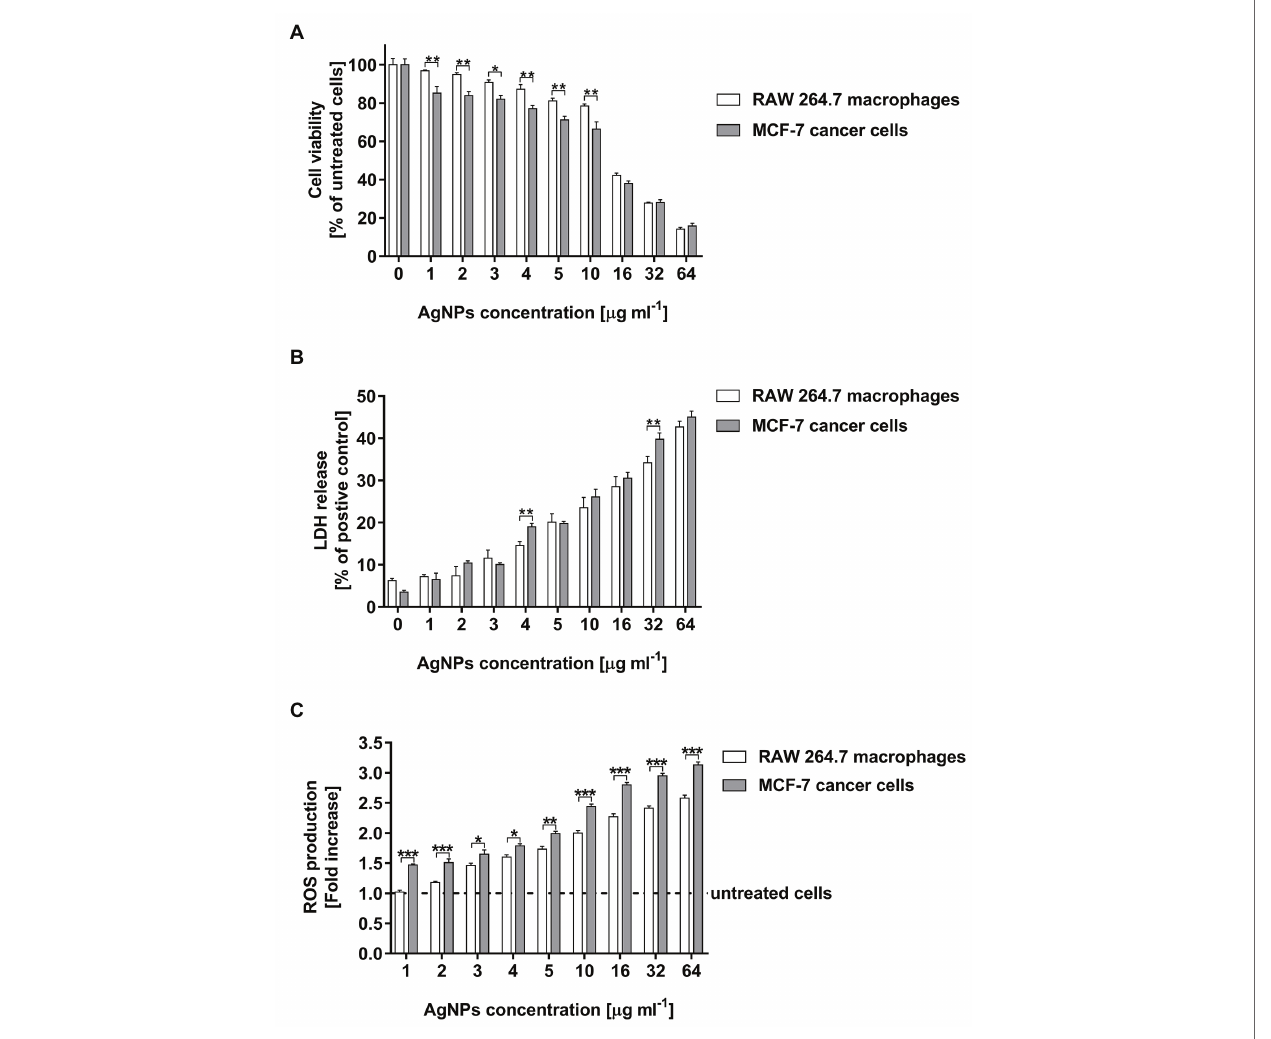
FIGURE 7 | Cytotoxic activity of biosynthesized AgNPs toward human breast cancer cell line (MCF-7) and murine macrophage cell line (RAW 264.7) estimated by MTT assay (A) , LDH release (B) , and ROS production level (C) . Asterisks indicate significant differences between the viability of cells, the levels of LDH released from cells, or the ROS production in cells of both cell lines (*** p < 0.001; ** p < 0.01; * p < 0.1).